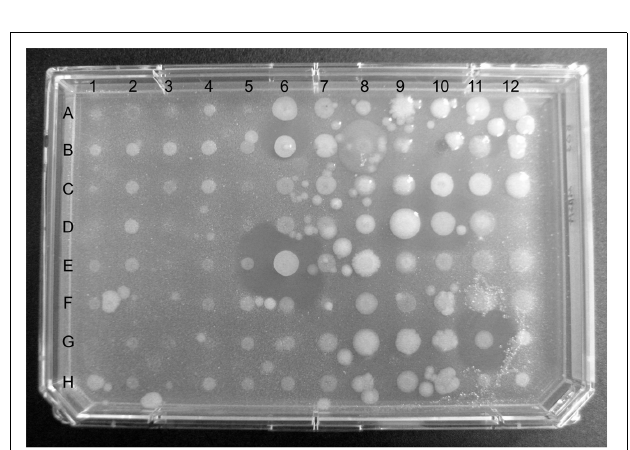
FIGURE 3 | Plate containing 96 of the 960 bacterial strains cultured from cownose ray ( Rhinoptera bonasus ) mucus overlaid with methicillin-resistant Staphylococcus aureus (MRSA). Diameters of zones of inhibition in wells E6 and G11 are 7.5 mm and 6.0 mm,